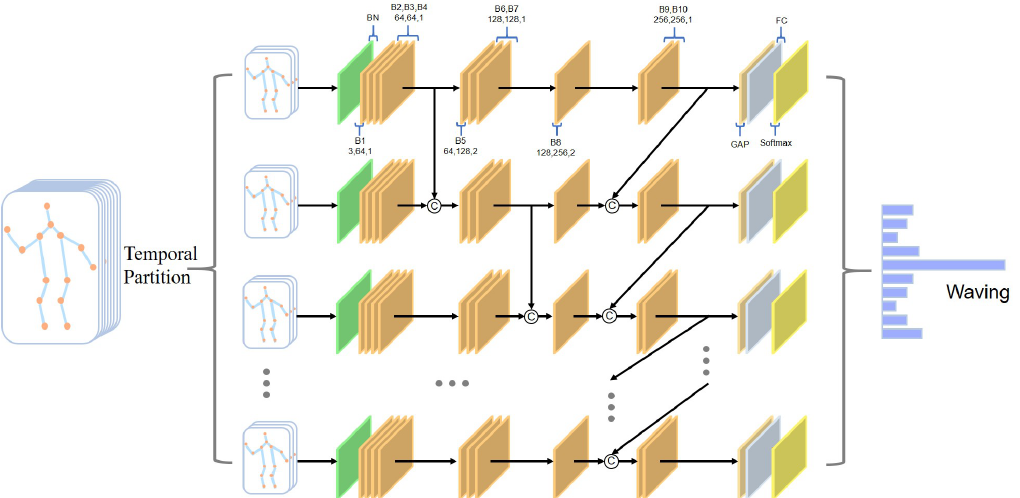
Figure 7. Network architecture of